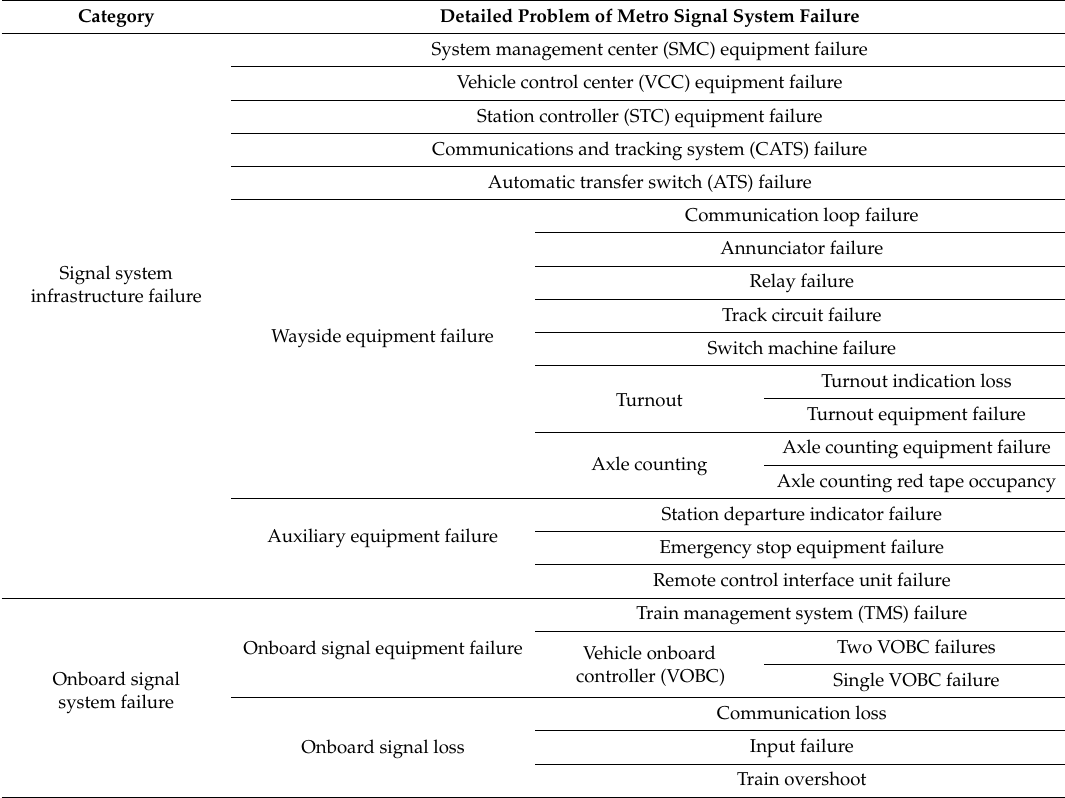
Table 1. The taxonomy of a metro signal system